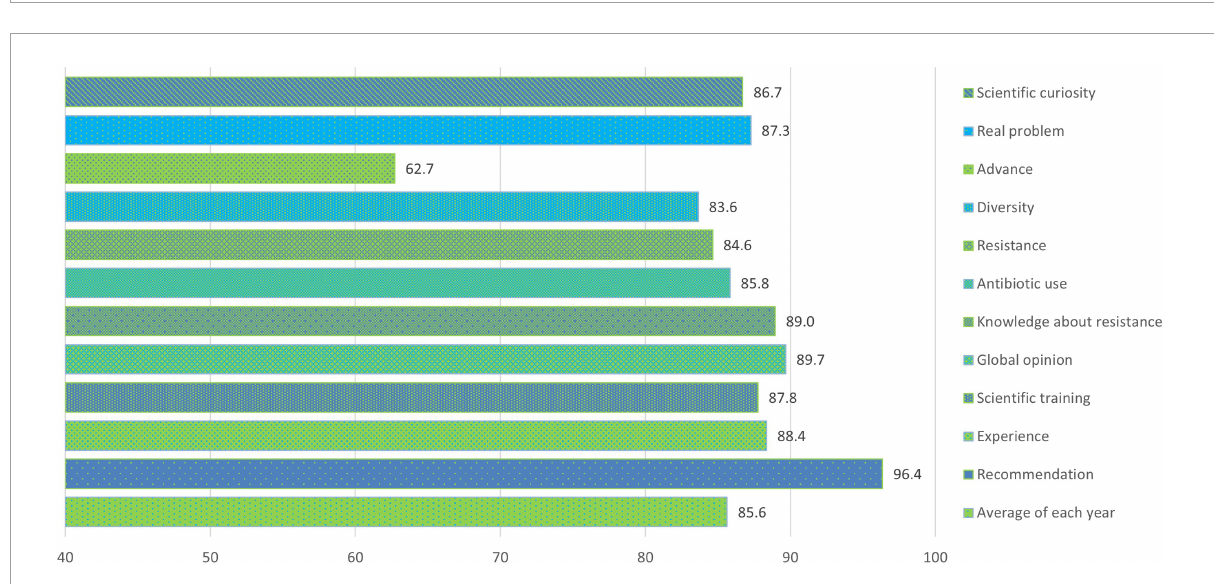
FIGURE3 Percentages of the average values of satisfaction of each issue in pre-university students at the end of the SWICEU project during the 2017–2021 academic